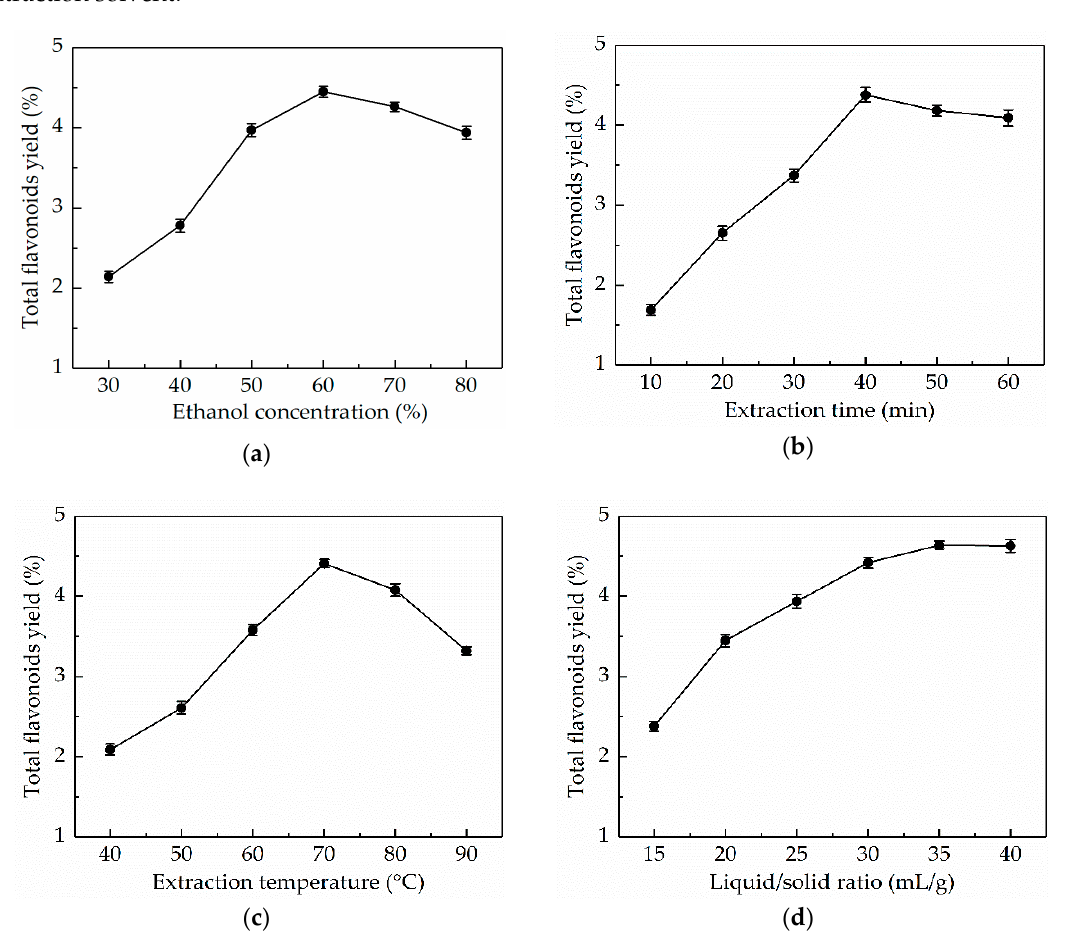
Figure 1. Effects of four independent variables on the total flavonoids yield (TFY): ( a ) Ethanol concentration; ( b ) extraction time; ( c ) extraction temperature; and ( d ) liquid/solid ratio.